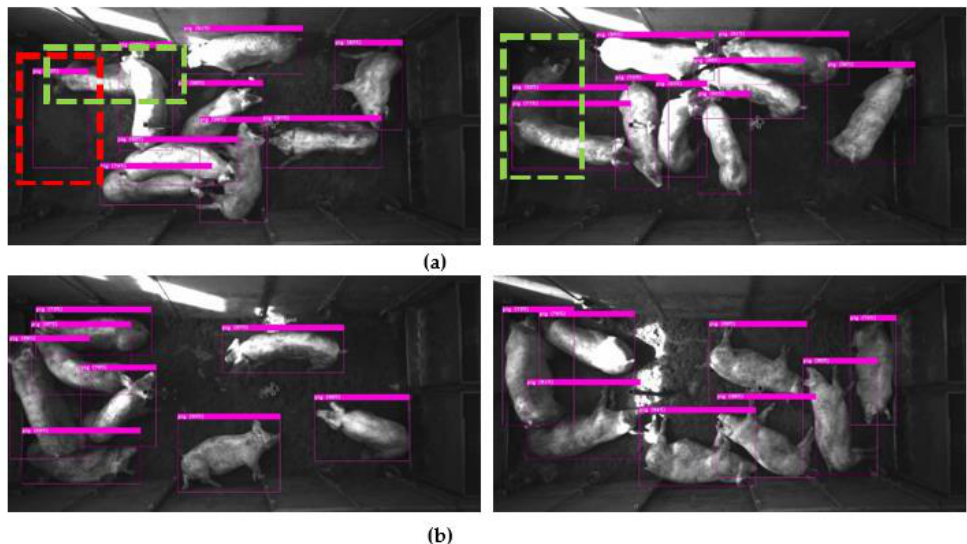
Figure 6. Limitations of ACC max_pigs when max_pigs = 9. ( a ) An “error” frame with one false-positive error and one false-negative error based on ground-truth (although it is regarded as a “correct” frame based on ACC max_pigs ); ( b ) a “correct” frame with no false positive/negative error based on ground-truth (although it is regarded as an “error” frame based on ACC max_pigs ).